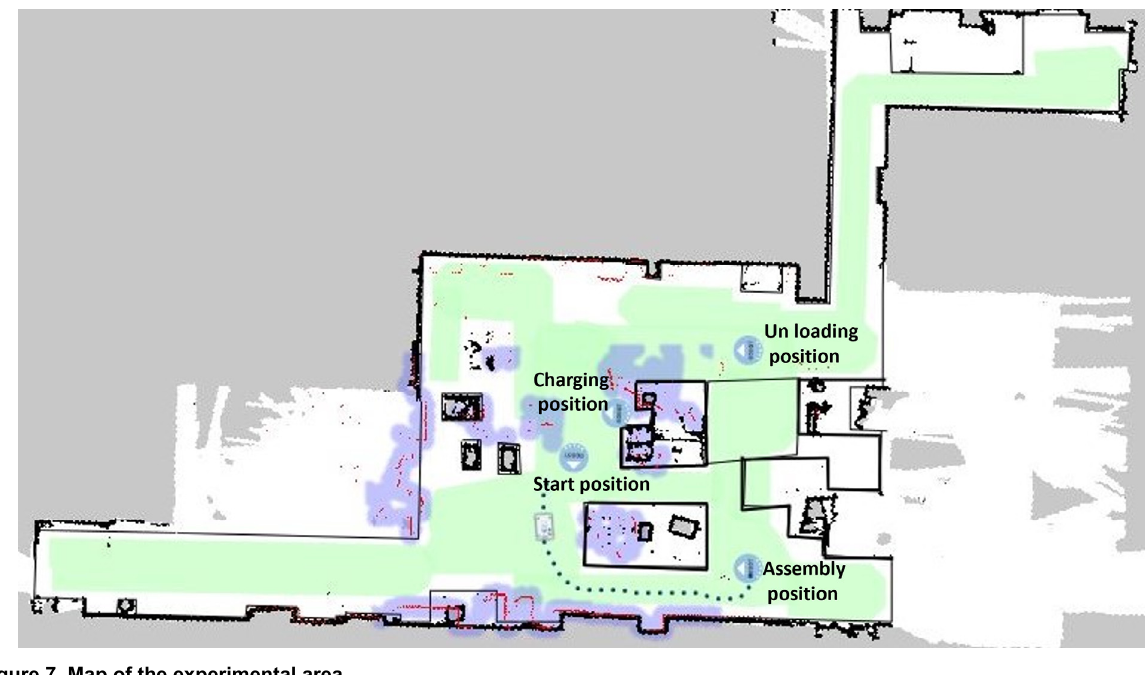
Figure 7. Map of the experimental area 5.